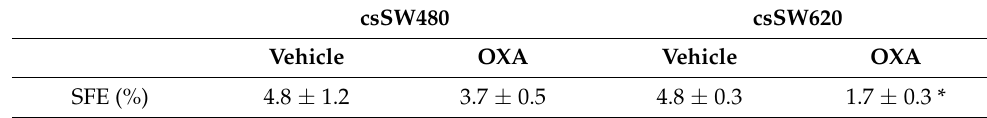
Table 2. Oxaliplatin effect on sphere formation efficiency in SW480 and SW620 tumourspheres. CRC cell lines were treated 96 h with vehicle (0.1% DMSO) or 5 µ M oxaliplatin. Data represent means ± SD ( n ≥ 4). Student’s test or Mann–Whitney test were performed to determine the signifi- cance between the experimental groups. Statistical significance was set at * p <